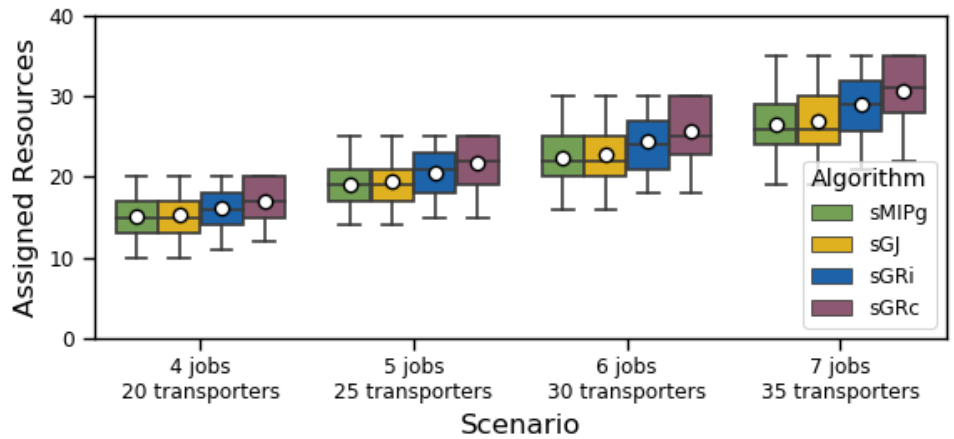
Figure 7. Distribution of assigned transporters (using the same boxplot settings as in Figure 5). Whenever an instance is infeasible, this number is set to the total number of